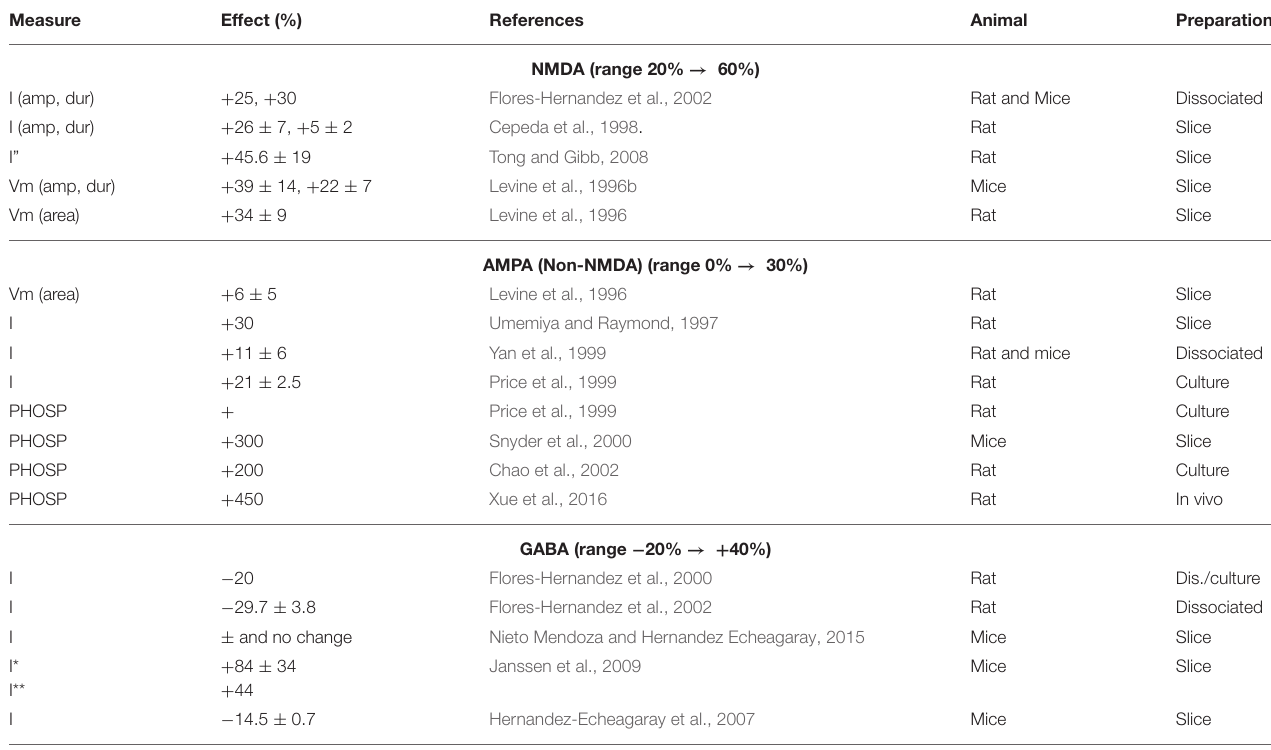
I stand for current, amp stands for amplitude, dur stands for duration, Vm stand for membrane potential, and PHOSP stands for phosphorylation. I” indicates current in adult animals (reduced in juvenile). I * indicates tonic current from low levels in young animals. I ** stands for tonic current following application of D1R antagonist in adult animals. Some values are estimated from multiple values or